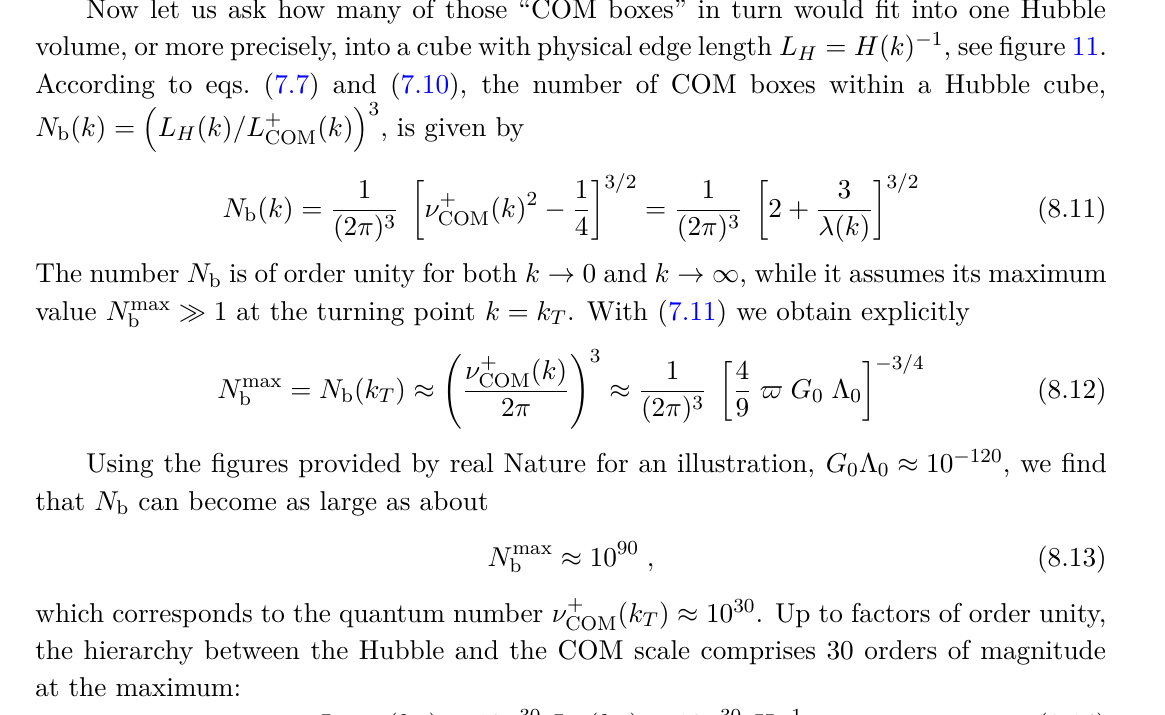
Figure 11. Filling a Hubble volume with L + evaluation point x j of the function A ( x ) , see subsection